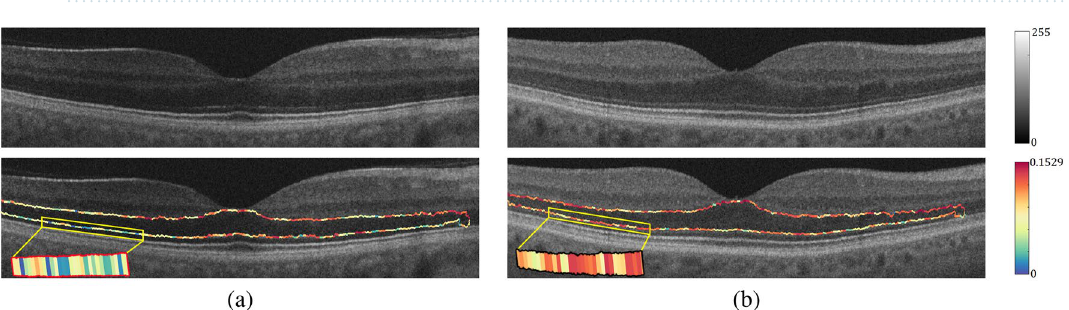
Figure 9. Two examples of the estimated point-wise correspondences for the ONL layer for a normal ( a ) and a DR ( b ) case.